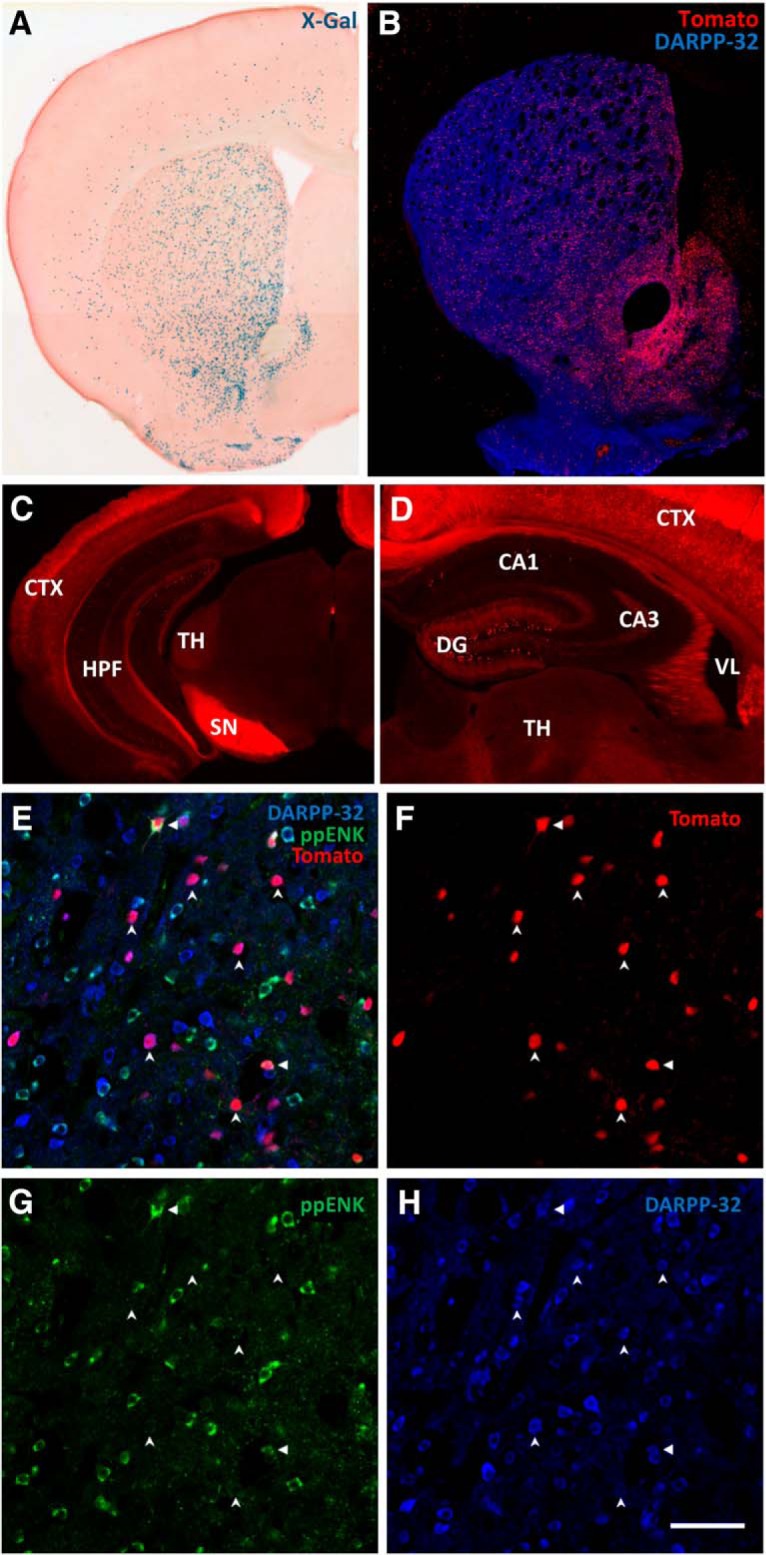
Recombinase expression in the D1CreERT2 strain. A, A micrograph of a coronal section from the brain of an R26Rosa-D1CreERT2 mouse stained with X-Gal and eosin. The blue product of beta-galactosidase activity is primarily visible in the NAc and in the ventral and medial striatum. B, Confocal image showing a coronal section from the brain of a tdTomato-D1CreERT2 mouse. MSNs visualized by an antibody against DARPP-32; recombined neurons, by raw tdTomato fluorescence. A strong tdTomato signal is primarily observed in the NAc and in the ventral and medial striatum. C, D, D1CreERT2 activity in the hippocampus and the cortex. Micrographs of coronal sections from the brain of a tamoxifen-treated tdTomato-D1CreERT2 mouse. Recombined neurons visualized by raw tdTomato fluorescence. E–H, High-magnification of a coronal section of the NAc from a tdTomato-D1CreERT2 mouse showing tdTomato expression (F) in medium spiny neurons (MSNs) stained with antibodies against preproenkephalin (G; ppEnk) and DARPP-32 (H) and their composite image (E). Vertical arrows indicate examples of DARPP-32+, Proenkephalin−, and tdTomato+ cells (ie, recombined direct-pathway MSNs), whereas horizontal arrows indicate triple-positive cells (ie, recombined indirect pathway MSNs). Scale bar, 50 µm. CA1, Field CA1; CA3, field CA3: CPu, caudoputamen; CTX, cerebral cortex; DG, dentate gyrus; HPF, hippocampal formation; SN, substantia nigra; TH, thalamus; VL, lateral ventricle.